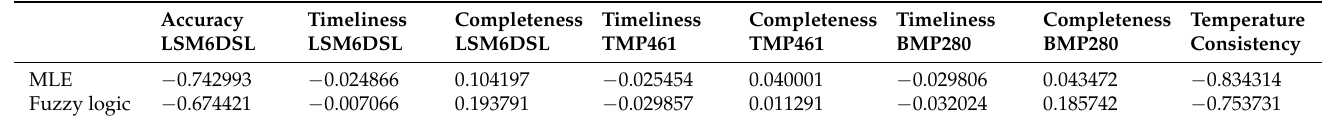
Table 4. Pearson’s correlation coefficients between data quality indicators and data quality attributes of Accelerometer Data Set.